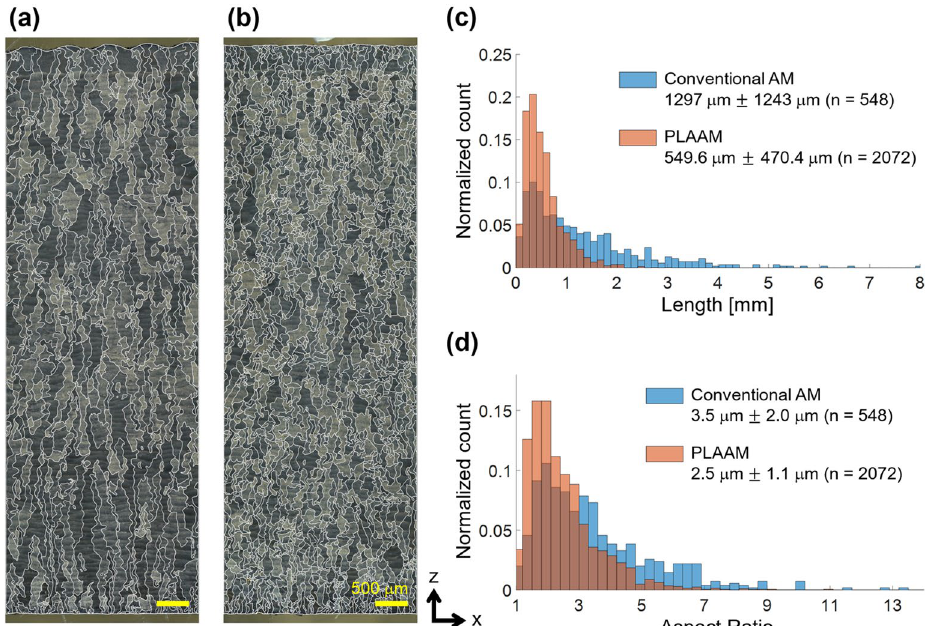
Figure 2. Change in prior-β grain structure. OM images along the build direction of conventional AM ( a ) and PLAAM ( b ) samples. z and x are the build and transverse directions, respectively. Histograms of the length ( c ) and aspect ratio ( d ) of the prior-β grains observed in ( a ) and ( b ). The overlapped histograms are shown in a darker